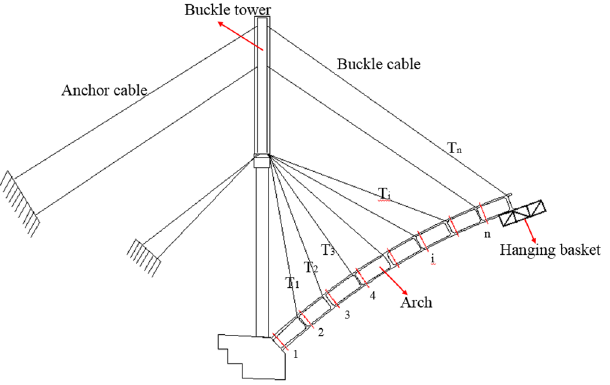
Figure 1. Cantilever casting arch rib construction